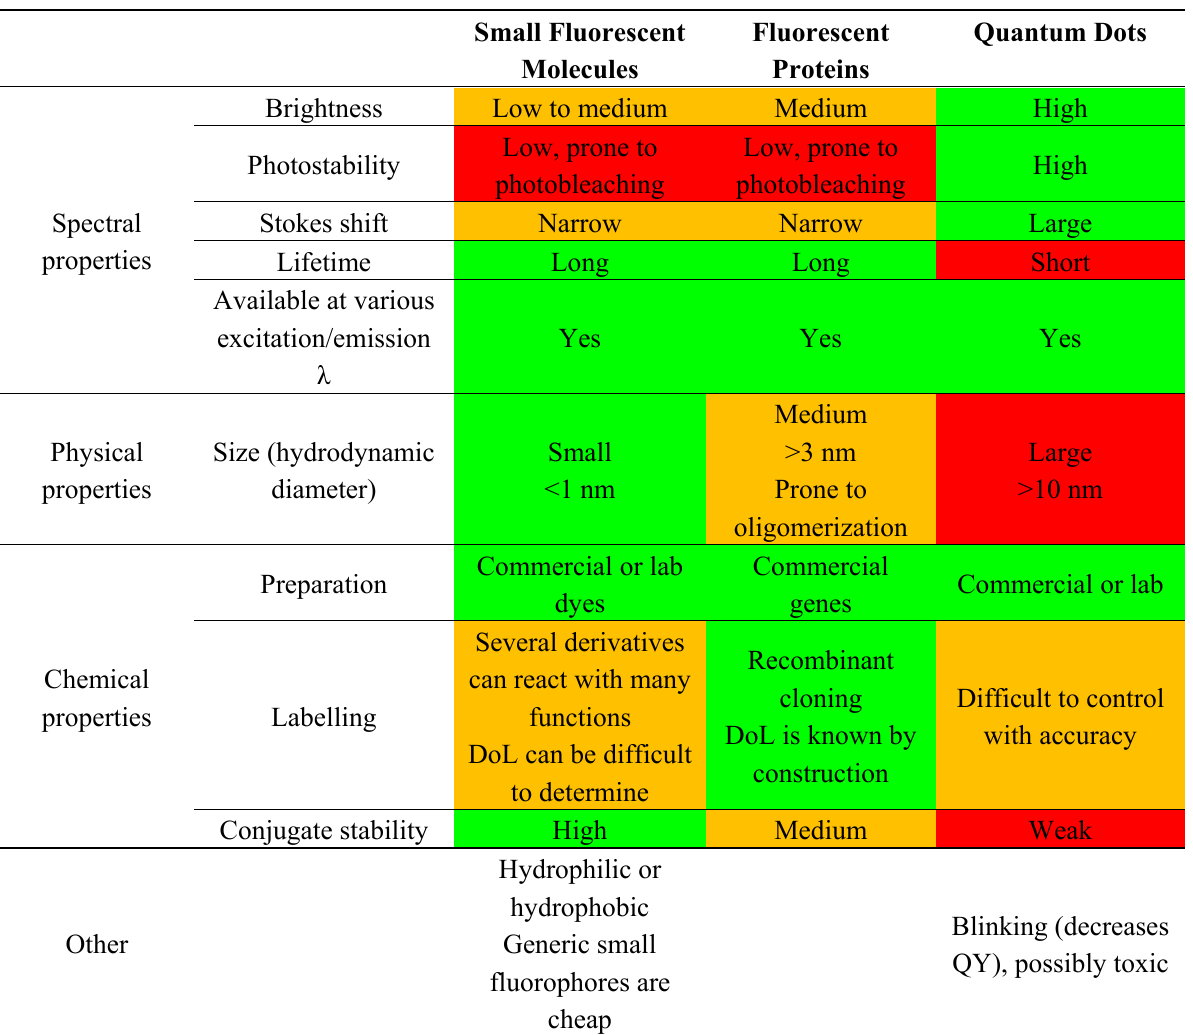
Table 2. Comparison of the major properties of fluorophore classes used for investigating PCWs. Properties are highlighted in 3 different colours to indicate, in the case of PCW imaging, if they are advantageous (in green), detrimental (in red) or in-between (in orange). Please note that these are general trends and should be adjusted to specific